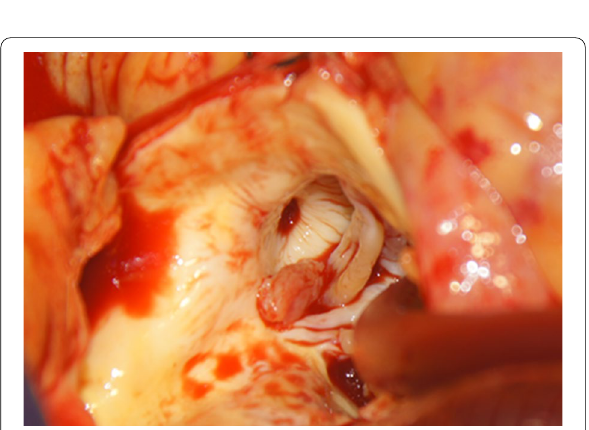
Fig. 2 Intraoperative findings: a 3 found to have occluded the left main coronary